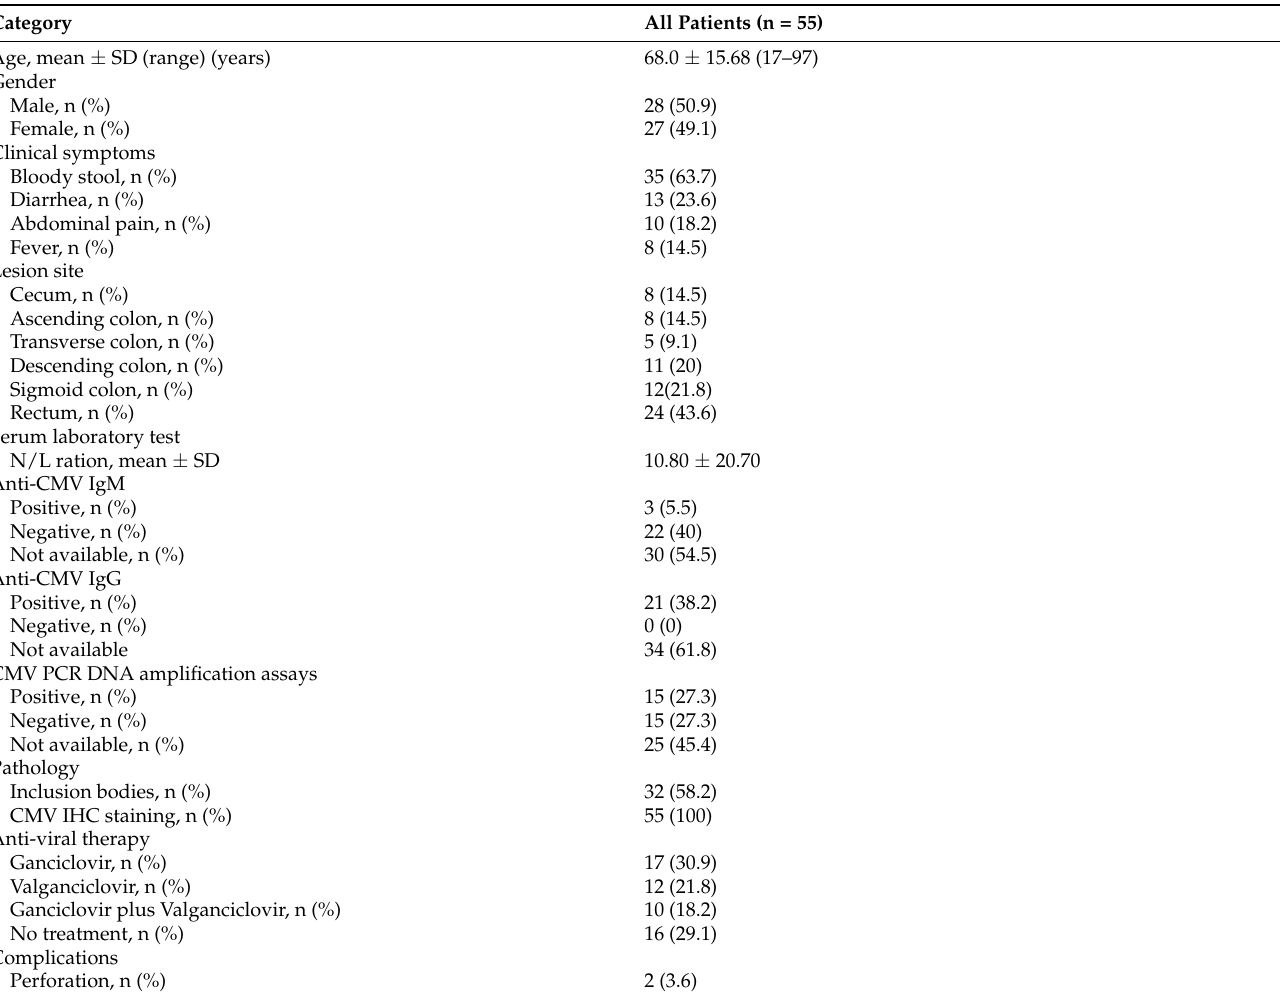
Table 1. Patient profiles of all the biopsy-proven CMV colitis cases (n =